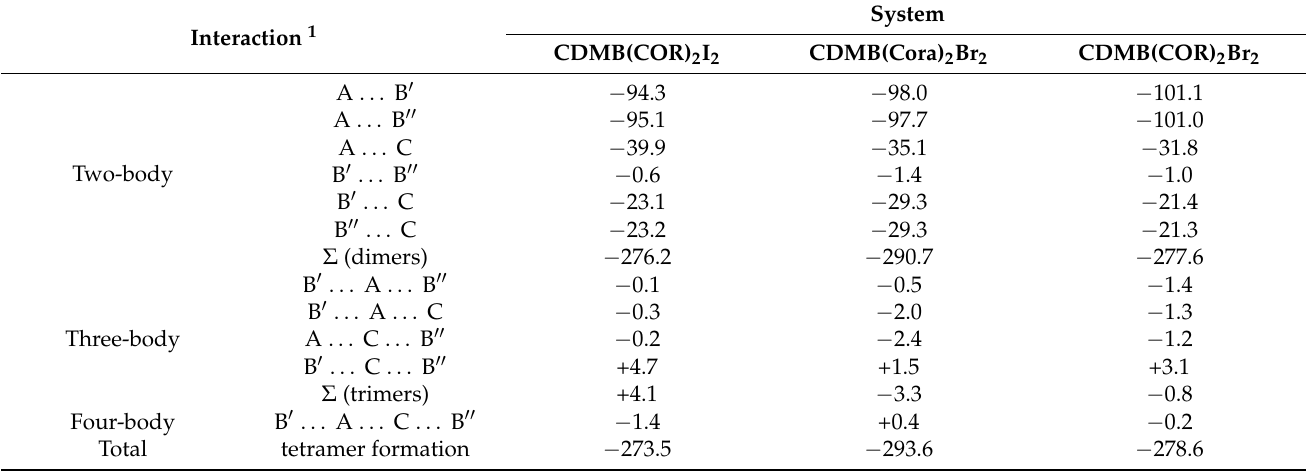
Table 4. The breakdown of contributions to ∆ E ABCD tetramer (in kJ/mol) of the three investigated